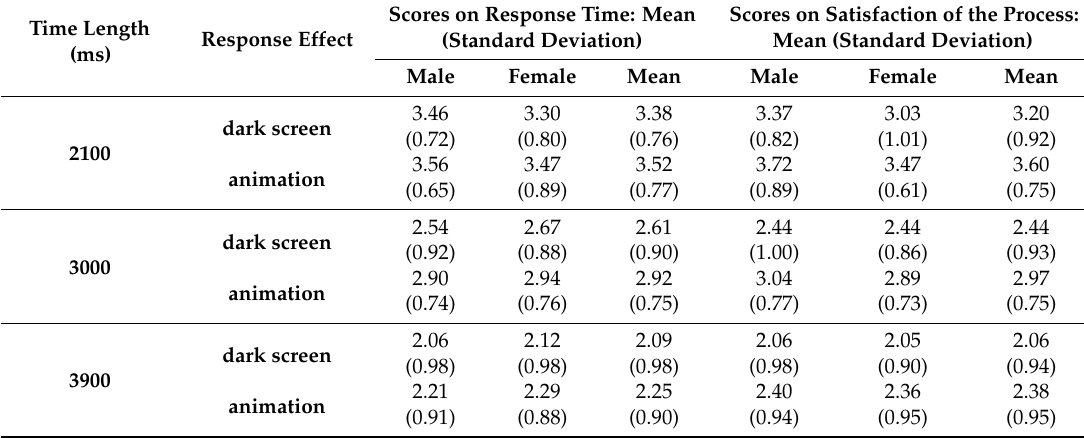
Table 2. Gender specified scores for the scenario of initialization of WeChat TM